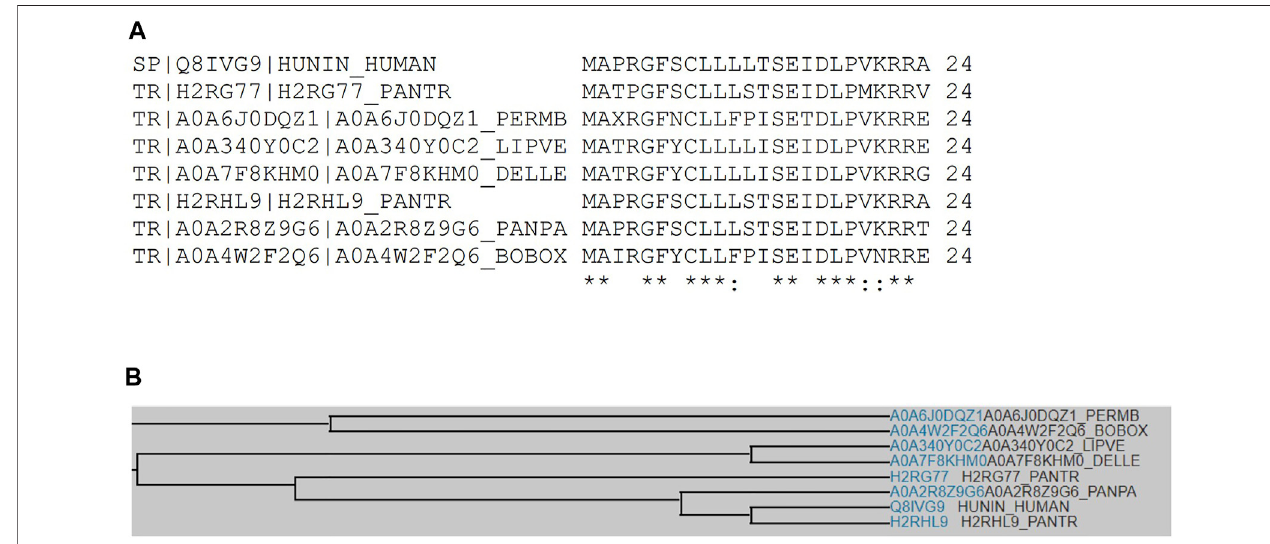
FIGURE2|(A) MultiplesequencealignmentanalysesshowthathumanHNsharessequenceidentityorsimilaritytoChimpanzee,Prairiedeermouse,Yangtzeriver dolphin, Beluga whale, Bonobo, and hybrid cattle. (B) A family tree of HN among these species is presented.